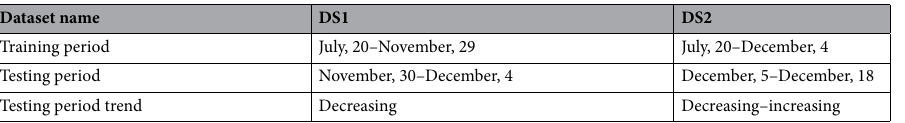
Table 1. Datasets for training and testing ML algorithms. They include different periods with different spatio- temporal